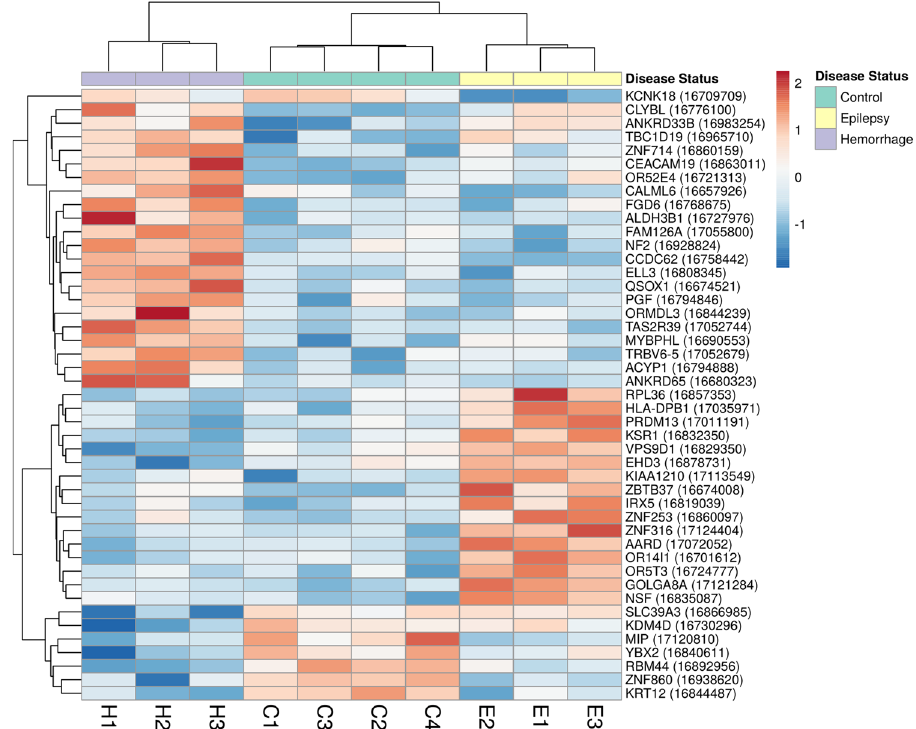
Figure 4. Hierarchical clustering heatmap for the expression of CvsEvsH DEGs. The delineated differential gene expression DGE profile highlights clustering of samples according to their sample group. Red color and blue color show relatively higher and lower gene expression,